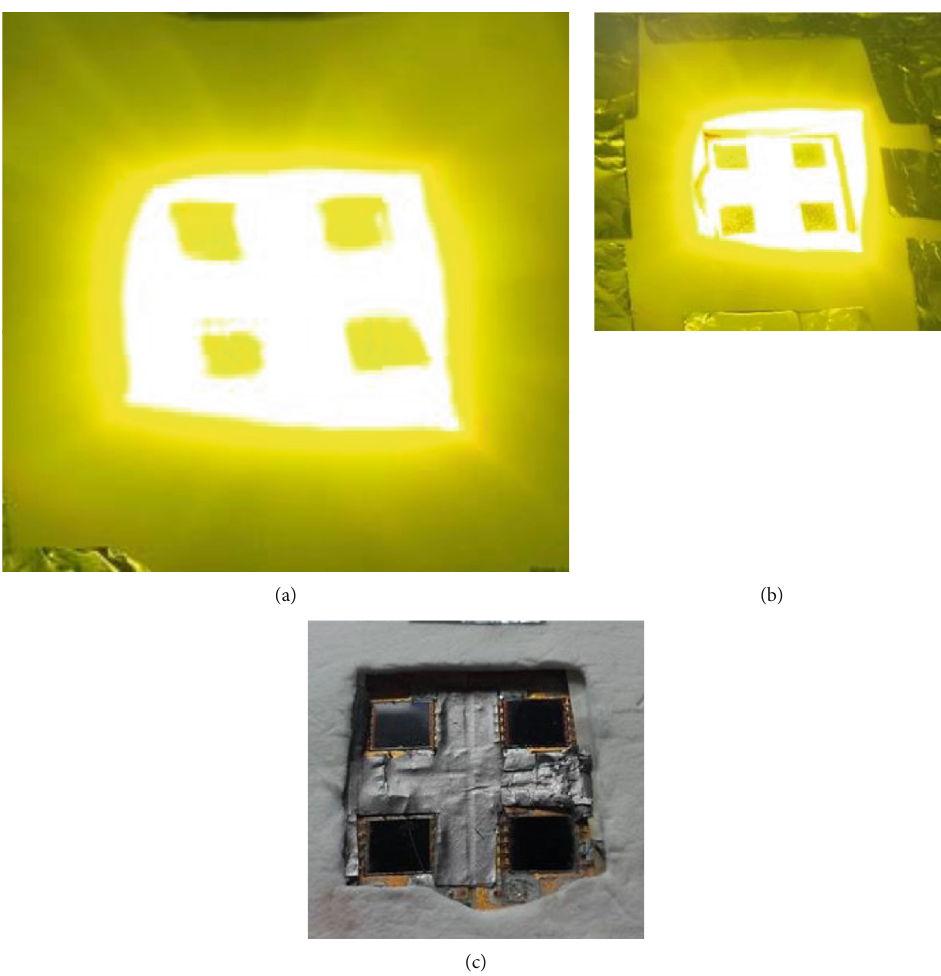
Figure 5: The tested con fi gurations of HS: (a) with alumina cross; (b) without alumina cross; (c) with graphite sheet.